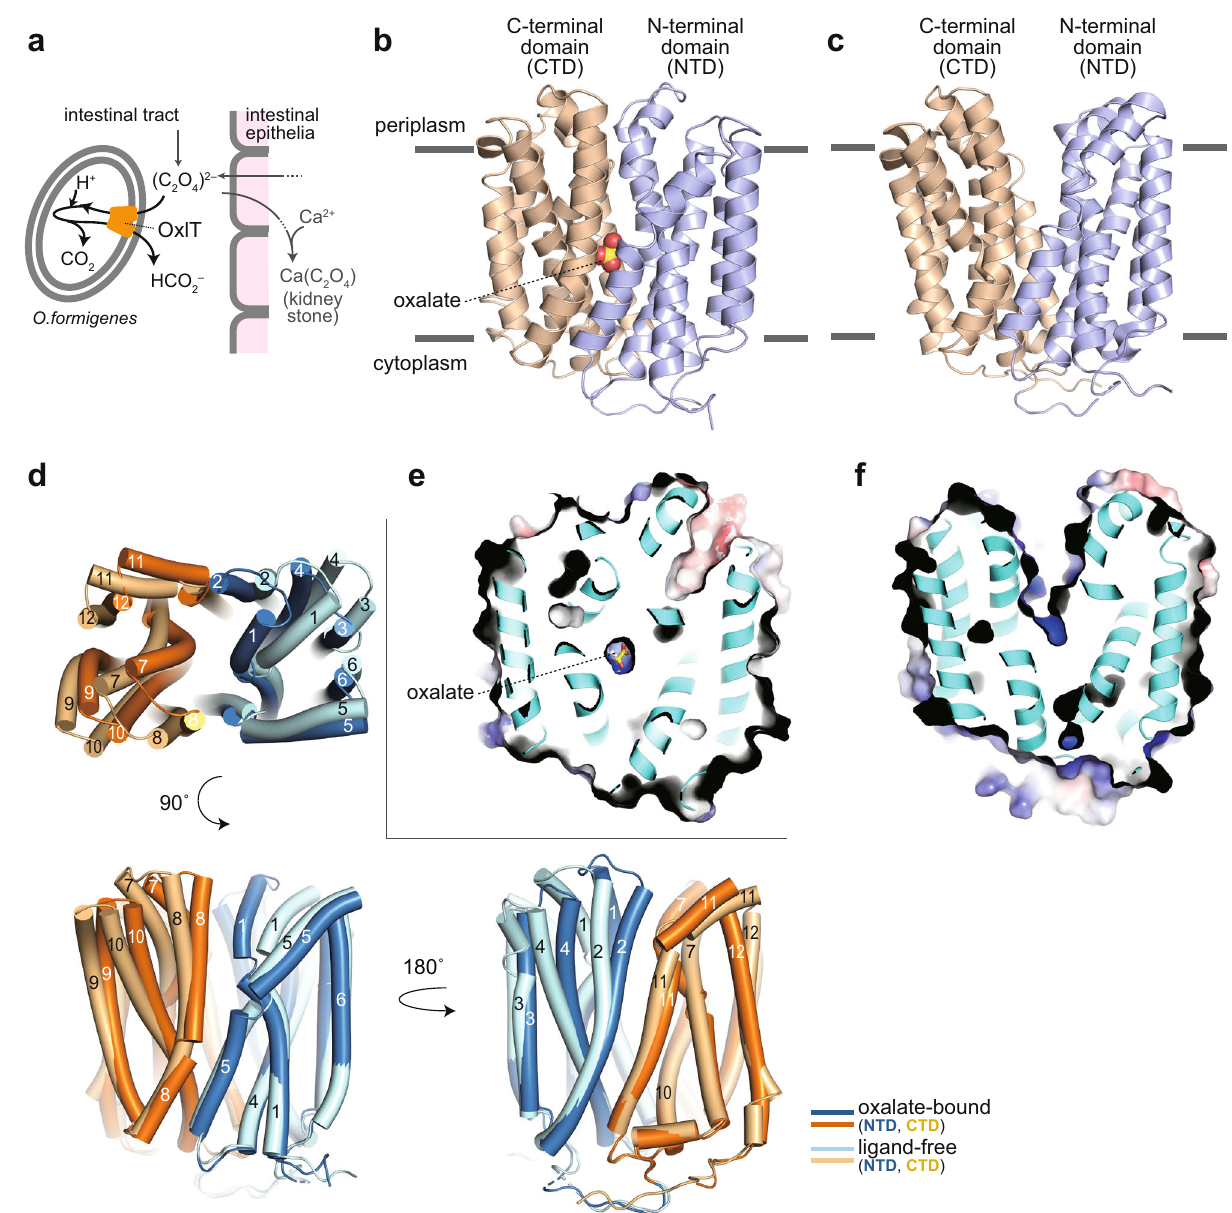
Fig. 1 | Structure of OxlT. a Schematic drawing of OxlT function in the oxalate- degrading bacterium, O. formigenes , in the gut. b , c Crystal structures of the oxalate-bound (PDB ID 8HPK; b ) and ligand-free (PDB ID 8HPJ; c ) OxlT. d Superpositionof oxalate-boundandligand-freeOxlT.Aviewfromtheperiplasm